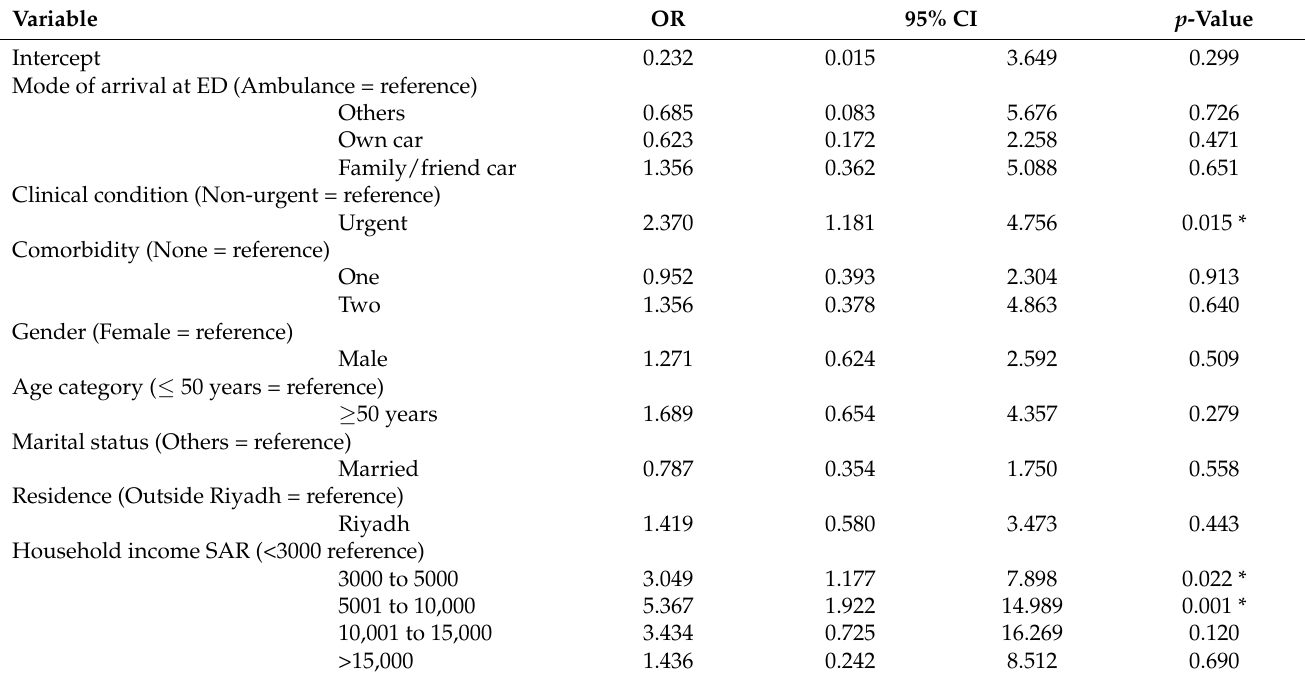
Table 3. Multivariate analysis of disposition and associated